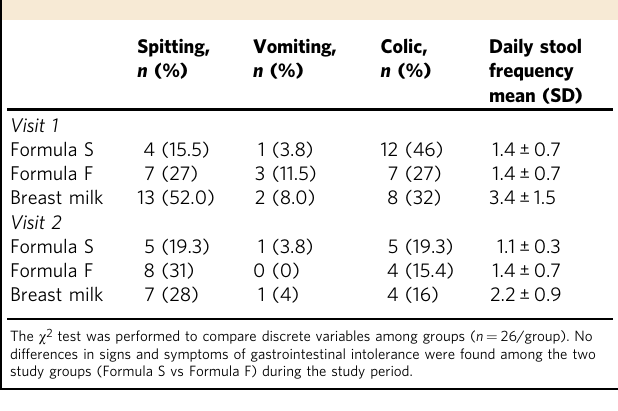
Table 2 Gastrointestinal tolerance.